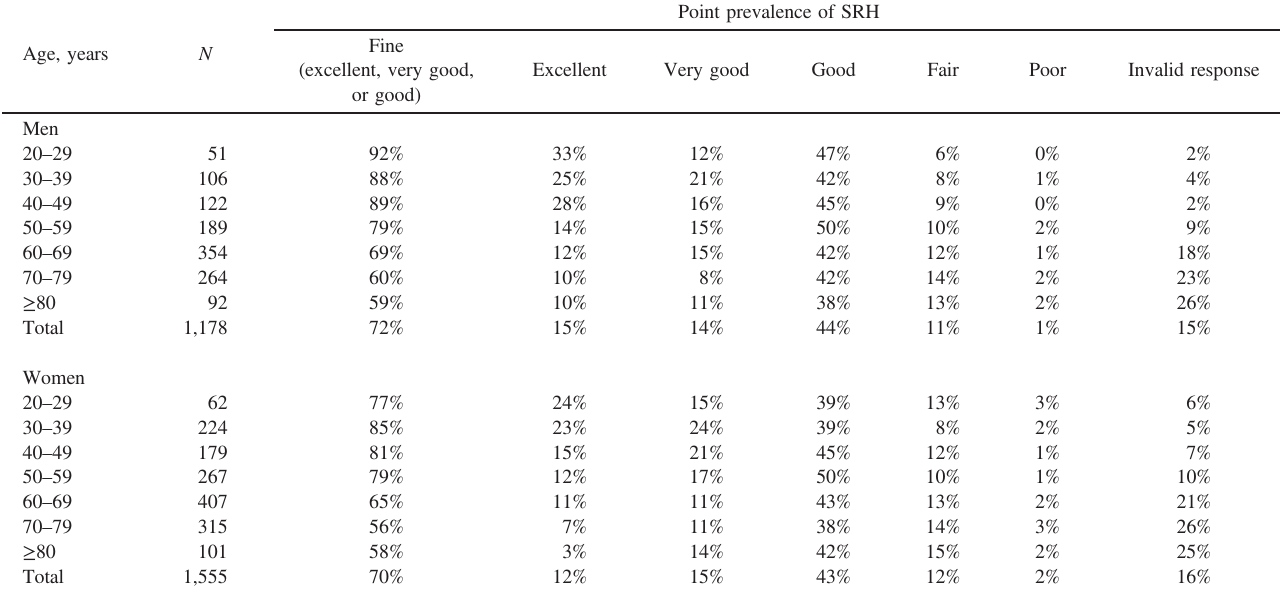
Table 1. Self-rated health conditions of subjects: NIPPON DATA2010 Point prevalence of SRH Fine Age, years N (excellent, very good, Excellent Very good Good Fair Poor Invalid or good)